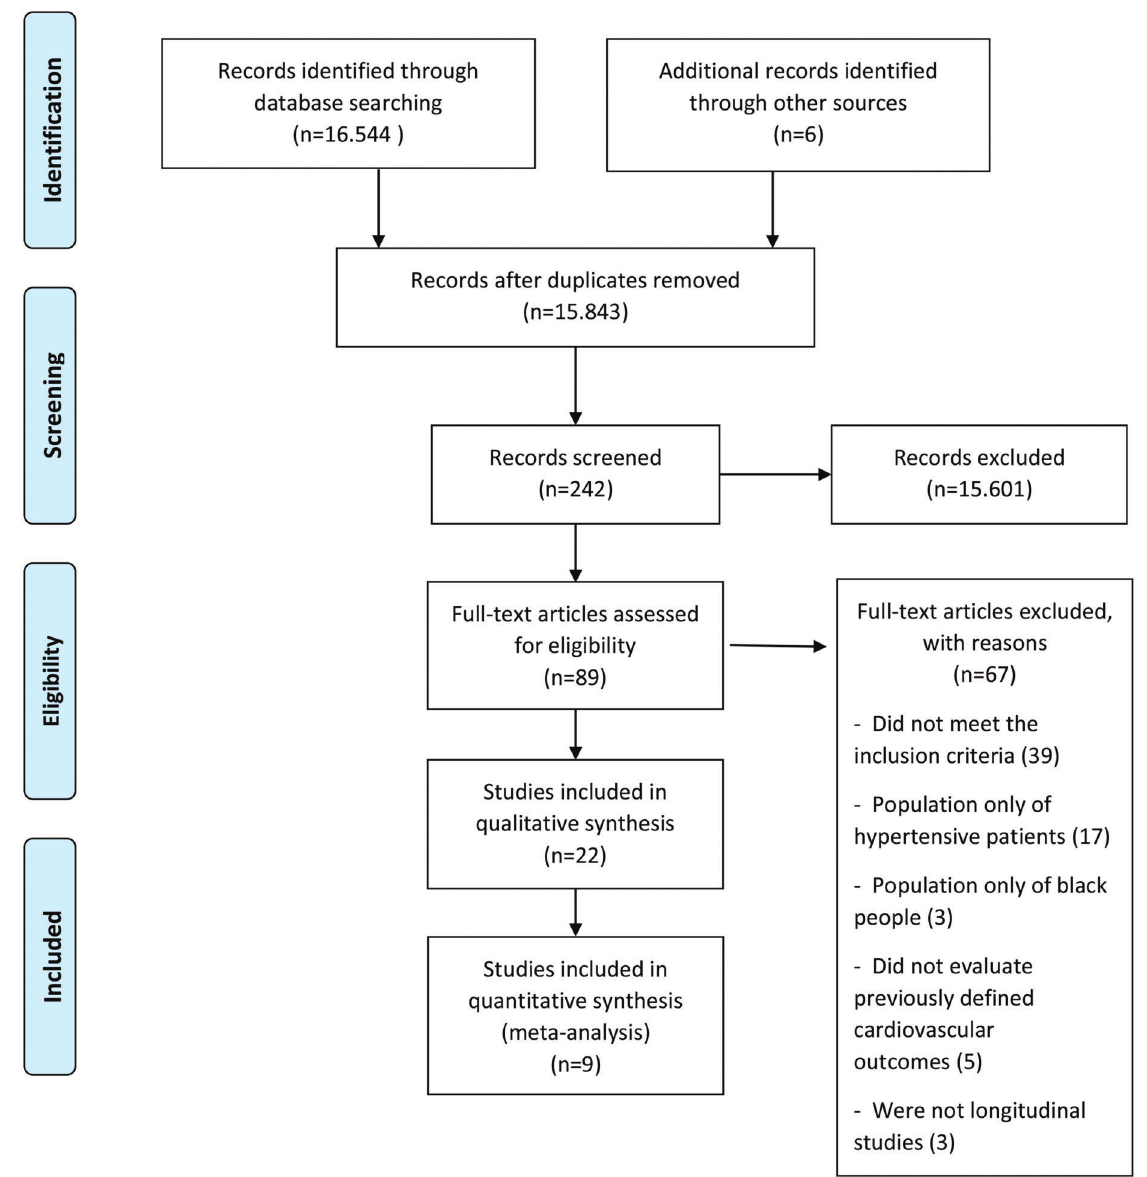
Figure 1 - PRISMA flow diagram showing study identification, selection, eligibility, and